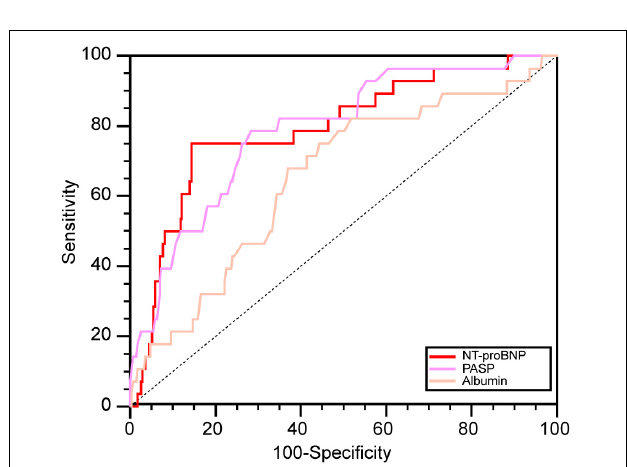
FIGURE 3 | The ROC curves of significant predictors. NT-proBNP, N-terminal brain natriuretic peptide; PASP, pulmonary artery systolic pressure; ALB,